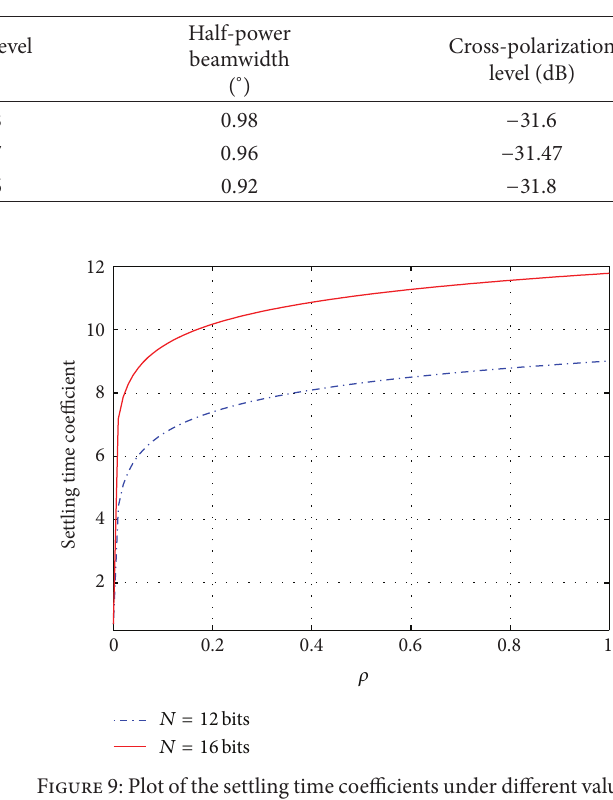
Figure 7: The simulation and measurement results of (a) primary polarization and (b) cross-polarization at frequency 94.5 GHz. Table 2: Measurement results of the W-band parabolic offset antenna.